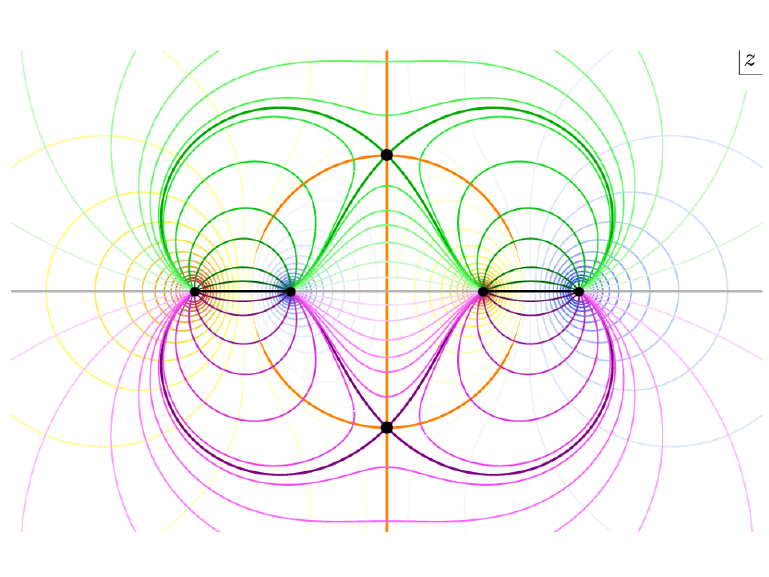
Figure 2 . Modular (cid:13)ow lines for 2 intervals, borrowed from [11]. The orange circle divides each of the intervals in the two halves, which are cut re-glued when they evolve pass the singularities at z (cid:6)